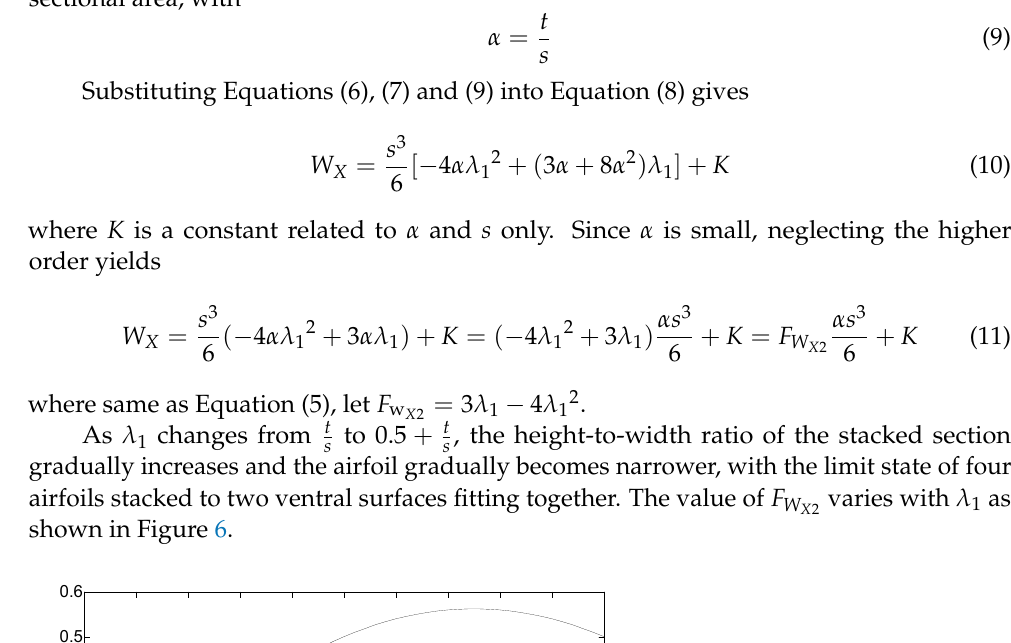
Table 2. Calculation results of section size